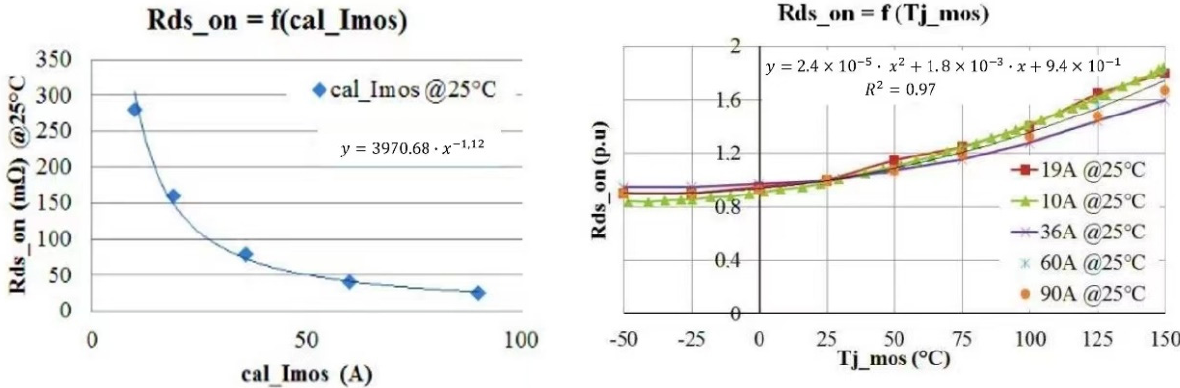
Figure 10. Variation of MOSFET ON state resistance according to its current rating ( left ) and ( right ) junction temperature.